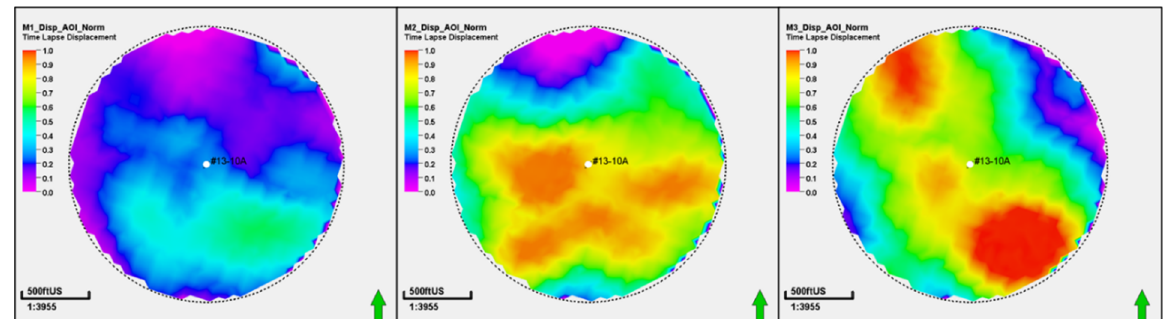
Figure 7. Normalized measured VSP depth shift below the injection interval in injector 13–10A for; ( left ) monitor 1, ( center ) monitor 2, and ( right ) monitor 3.